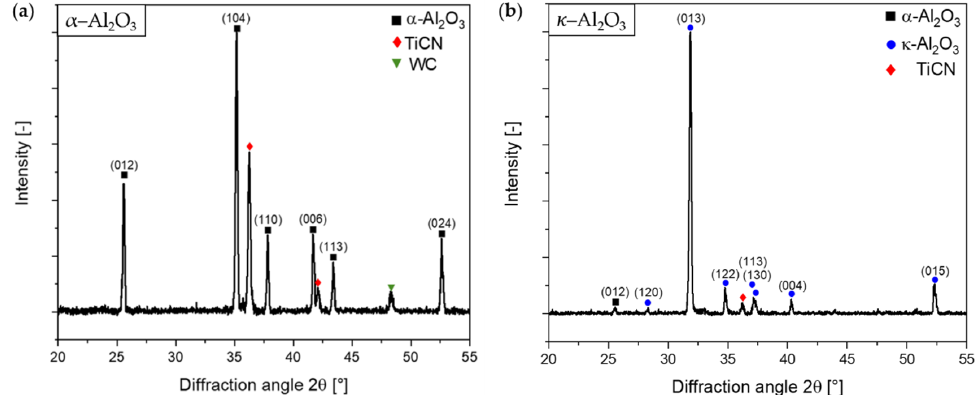
Figure 1. X-ray diffractograms of CVD ( a ) α –Al 2 O 3 and ( b ) κ –Al 2 O 3 coatings deposited on cemented carbide substrates with a TiN base layer and a TiCN intermediate layer.